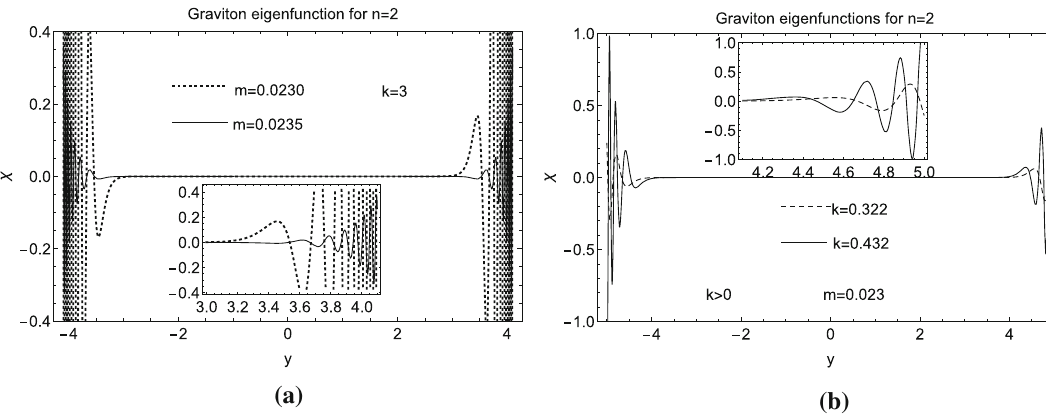
Fig. 8 Massive modes for n = 2 and k 0 = α = β = 1, varying the mass eigenvalue ( a ), and varying k ( b )